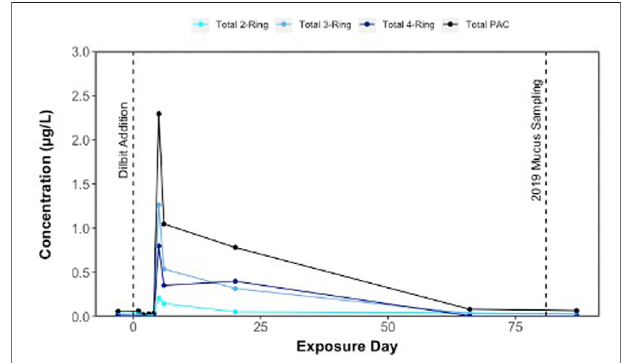
FIGURE 1 | Concentrations (µg/L) of polycyclic aromatic compounds (PACs) in surface waters of Lake 260 following dilbit addition into fourteen shoreline enclosures on the lake on Day 0 (22 June 2019). Lake charr epidermal mucus was sampled on Day 81 (10 September